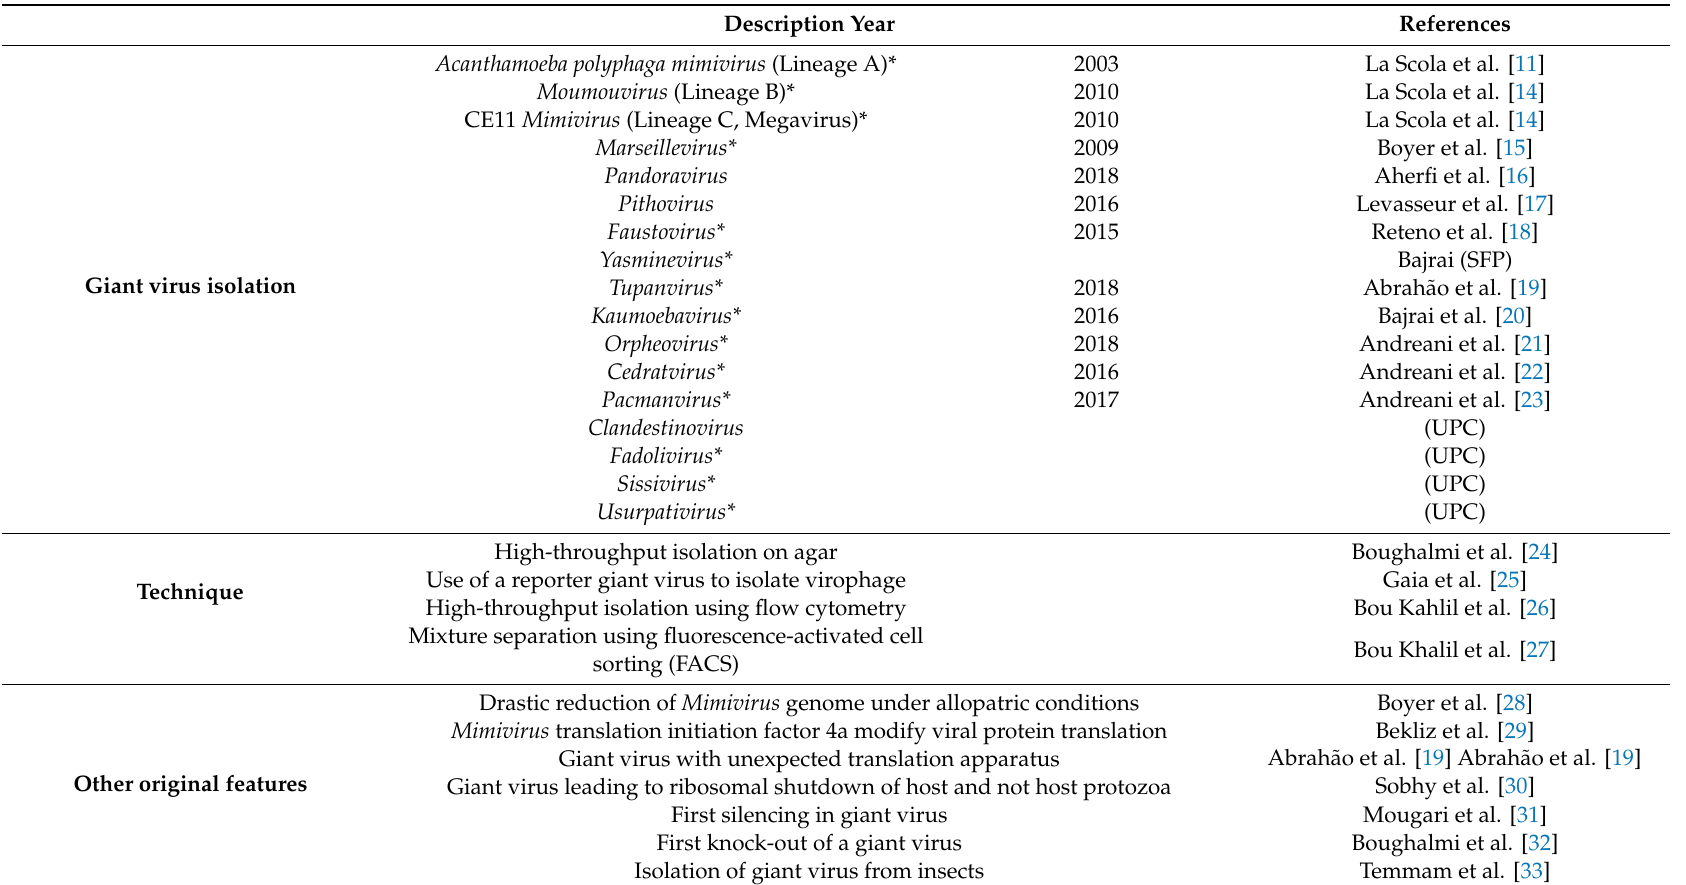
Table 1. Input of the University Hospital Institute (IHU) Mediterranee Infection to the knowledge of giant viruses. (* First described by the laboratory; UPC: unpublished under